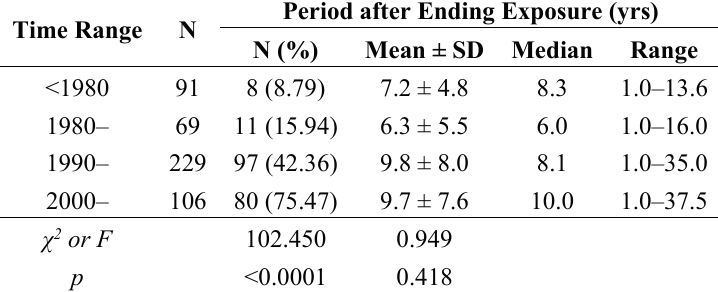
Table 3. The distributions of period after ending exposure of CWP in different diagnosis periods.